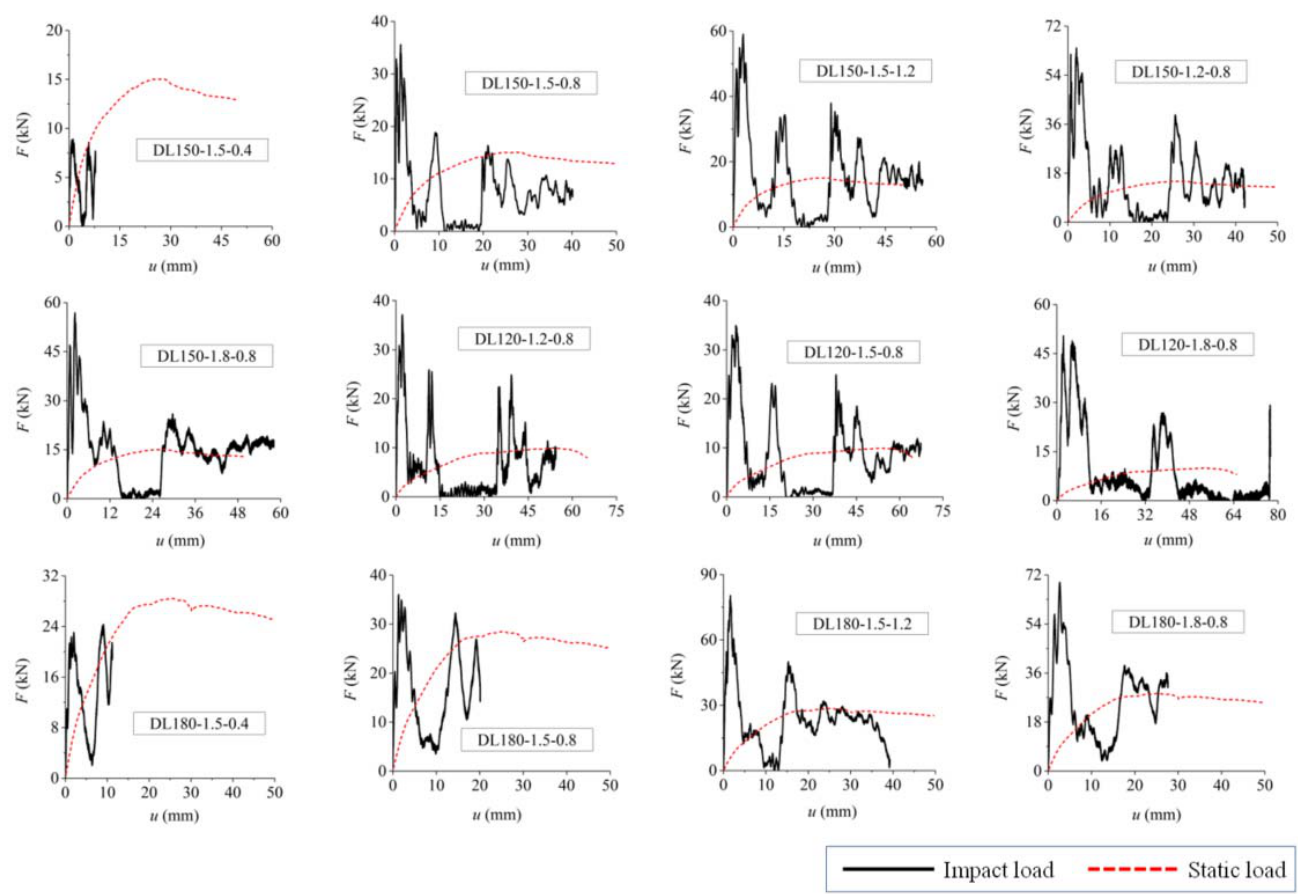
Figure 6. Load ‒ displacement curves under static and impact loading. Figure 6. Load–displacement curves under static and impact